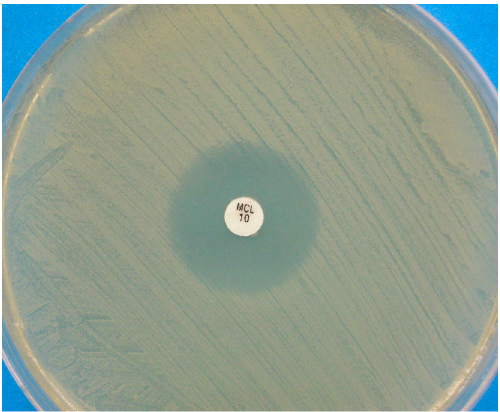
Figure 2. Disk diffusion assay for a Malassezia pachydermatis strain against miconazole, performed on Mueller-Hinton agar supplemented with 2% glucose and methylene blue. A clear inhibition zone edge is visible.